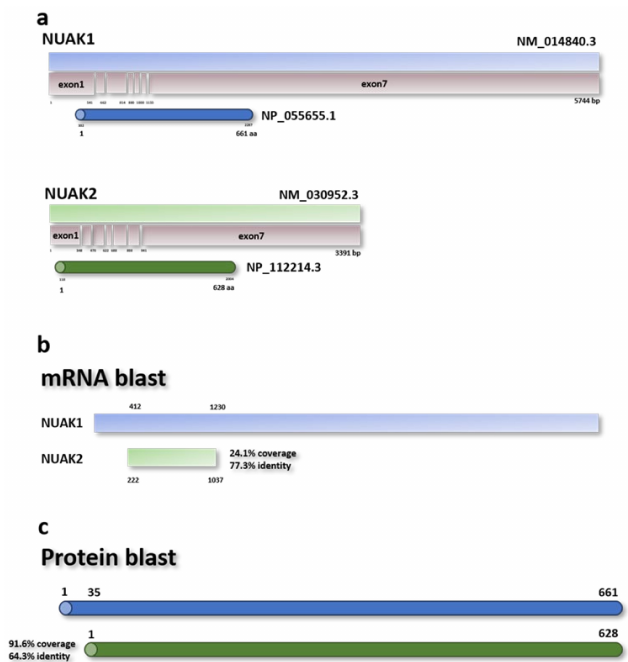
Figure 2. Scheme representation of the NUAK1 and NUAK2 genes. ( a ) The bars represent the length of the cDNA sequence, the exons encoded by the cDNA, and the coding DNA sequence that give rise to NUAK1 (above) and NUAK2 (below) proteins. NUAK1 is codified by 7 exons which expands for 5744 bp, whereas NUAK2 is codified by 3391 bp. However, both sequences translate into a similar size and sequence proteins. ( b , c ) Schematic representation of NUAK1 (blue) and NUAK2 (green) blast analysis of their mRNA ( b ) and protein ( c ) sequences. NUAK1 mRNA is longer compared with NUAK2, with a percentage of coverage around 24% with an identity (nucleotides in the same position) of 77%. NUAK1 and NUAK2 proteins have similar size but lower identity of around